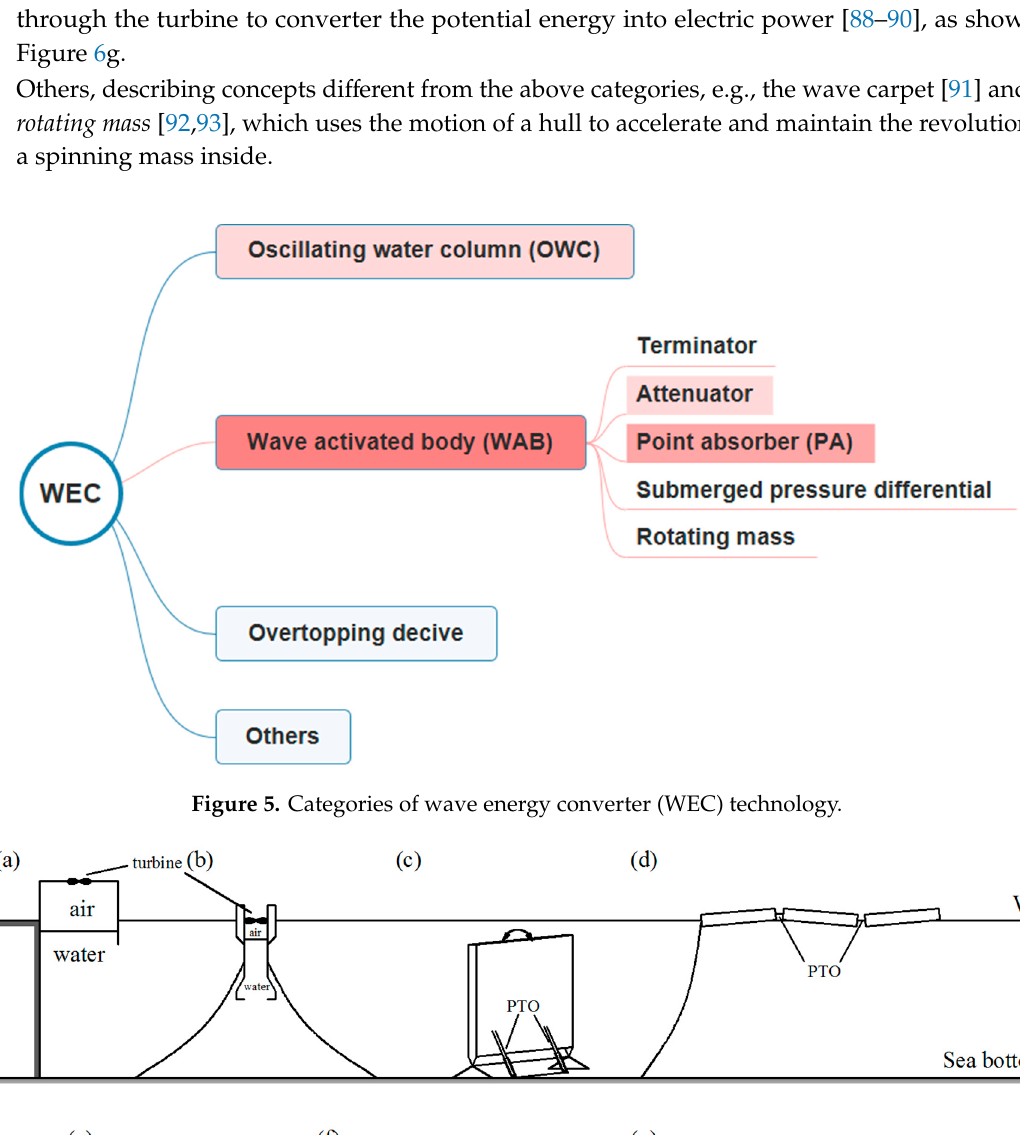
Figure 4. Main stages of wave energy conversion.